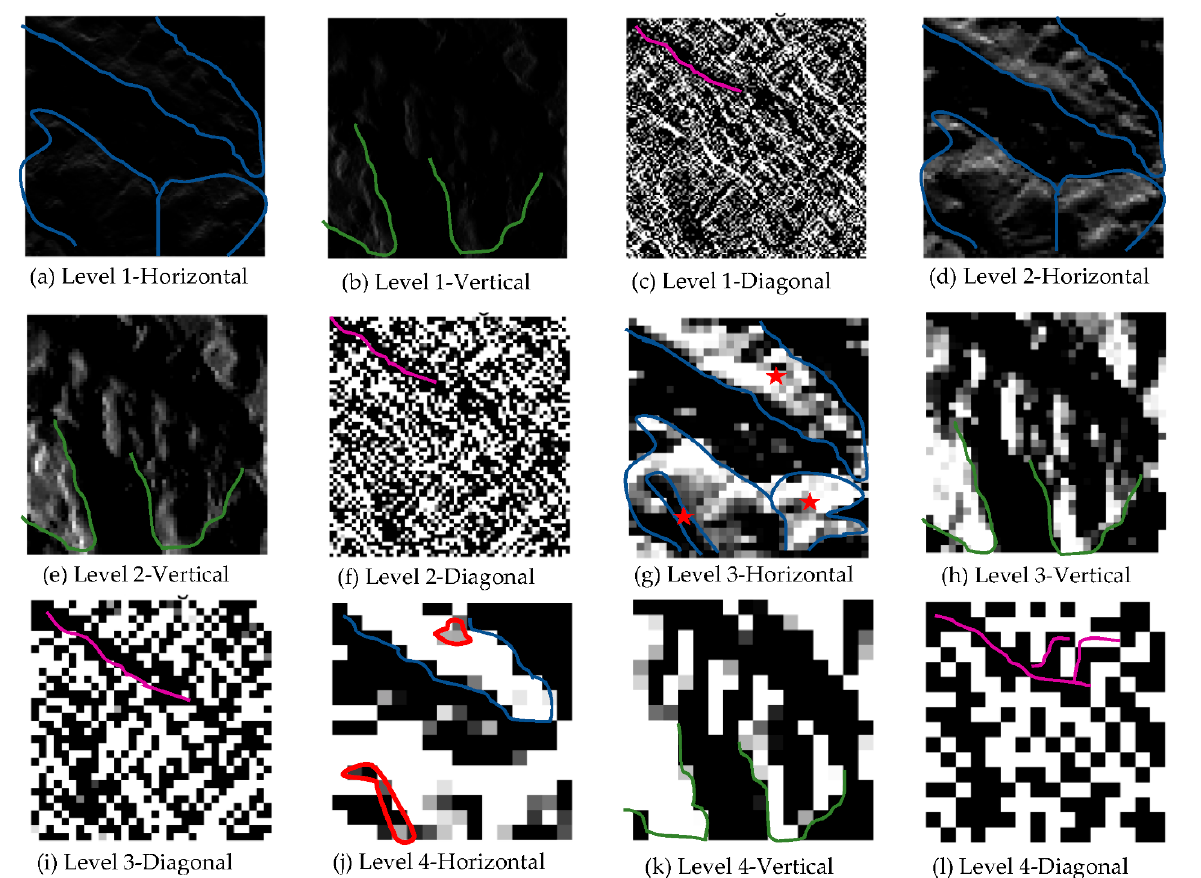
Figure 5. ( a – l ) High-frequency diagram of multiscale wavelet decomposition. After the high-frequency wavelet decomposition, in either the horizontal or vertical decomposition direction, the rough boundary of landform relief can be seen from level 1, 2, and 3, marked by blue and orange lines. Expressions of gray and white values are adopted to assess the magnitude of landform relief that is higher than the datum level (as the blue line shows), and the dark values indicate depression or the erosion intensity of the landform (as the orange line shows). However, when level 4 is reached, plentiful details of the landform are ignored, only a few pixels are left to maintain the morphology of the landform (as the red circle shows). This condition is inconsistent with the mountainous landform that is composed of several discrete units. Regarding the diagonal image, the valley line can be clearly observed (as the purple line shows), and when the mountain is decomposed to level 4, the small valley lines extend from the main trunk, which is contrary to the original landform morphology. The wavelet decomposition under level 4 results in geomorphologic distortion and noise redundancy. Therefore, level 3 is confirmed to decompose different landforms. It not only ensures the primary and secondary principles in landform synthesis, but also maintains the continuous and reasonable expression of landform